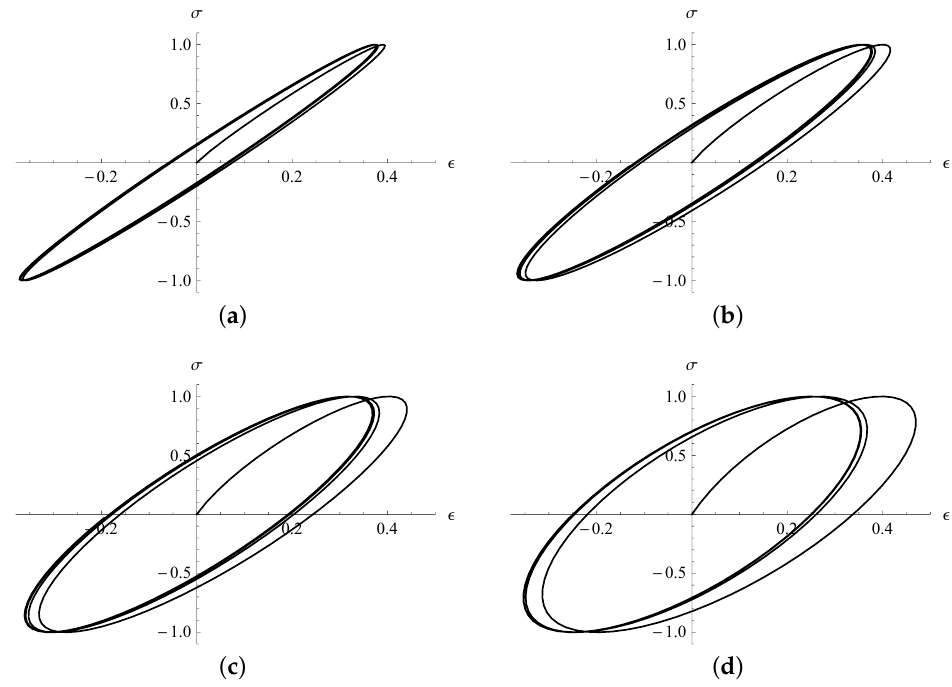
Figure 15. Stress–strain hysteresis loops for a = 0.5, b 0 = 1, and b 1 = 3 and for α = 0.25 ( a ), 0.5 ( b ), 0.75 ( c ), and 1 ( d ) in the fractional Zener